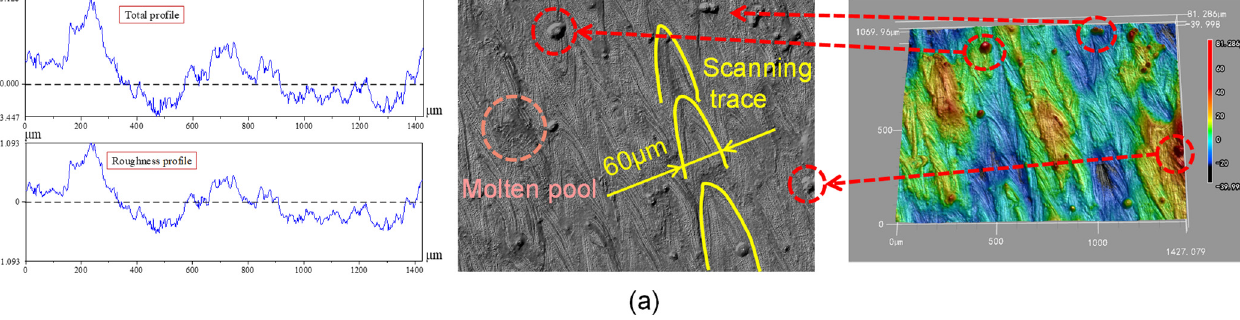
Figure 11. Surface profile, microscopic images and 3D surface analysis of Ti6Al4V fabricated by SLM. ( a ) SLM-VB; ( b ) SLM-PB-S; ( c ) SLM-PB-L. 4. Conclusions In this paper, the influence of building orientation for SLM Ti6Al4V with specific geometry on the microstructure, texture, mechanical and surface properties were studied comprehensively. For horizontal building orientation, the influence of two different con- tact modes with the substrate on the microstructure, mechanical and surface properties of the SLM samples was studied. In addition, the necessity of limiting the geometry of sam- ples and test surfaces was verified by comparing the study with existing results in the literature. The influence mechanisms of building orientation on multiple factors of micro- structure, mechanical and surface properties of SLM Ti6Al4V were clarified. To sum up, the following conclusions are reached. (1) In the SLM process, different building orientations resulted in different contact areas between the workpiece and the substrate, atmosphere and powder, which affected the heat conduction effect of the forming process. It led to different cooling rates (SLM-VB > SLM-PB-S > SLM-PB-L). The primary β phase was found in SLM-PB-S and SLM-PB-L, and the width of the primary β phase had the following size relation- ship: SLM-PB-S > SLM-PB-L. All the primary β phases grew along the building ori- entation.